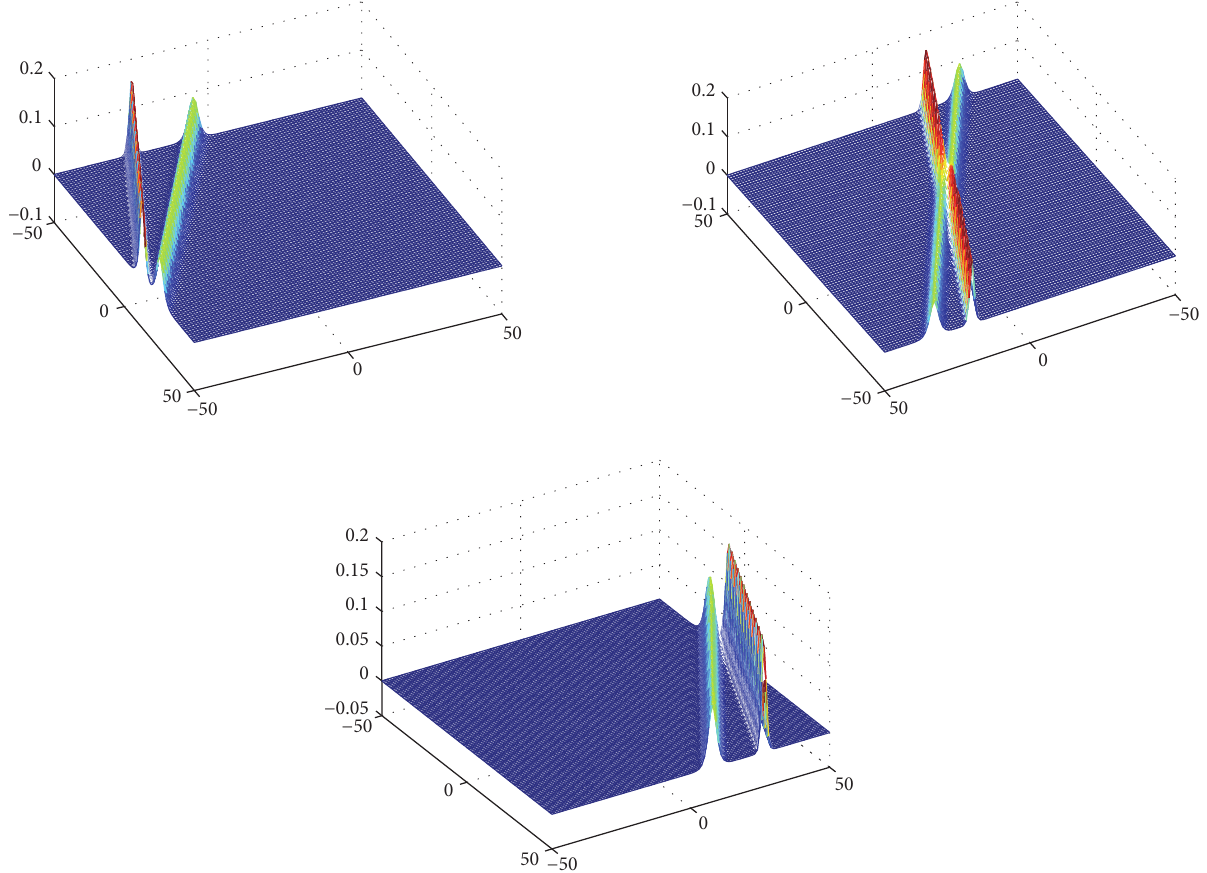
Figure 7: The pursue collision of (35) with 𝑘 1 = 0.6 , 𝑘 2 = 0.8 , 𝑙 1 = 1 , 𝑙 2 = 2 , and 𝑎 1 = 𝑎 2 = 0